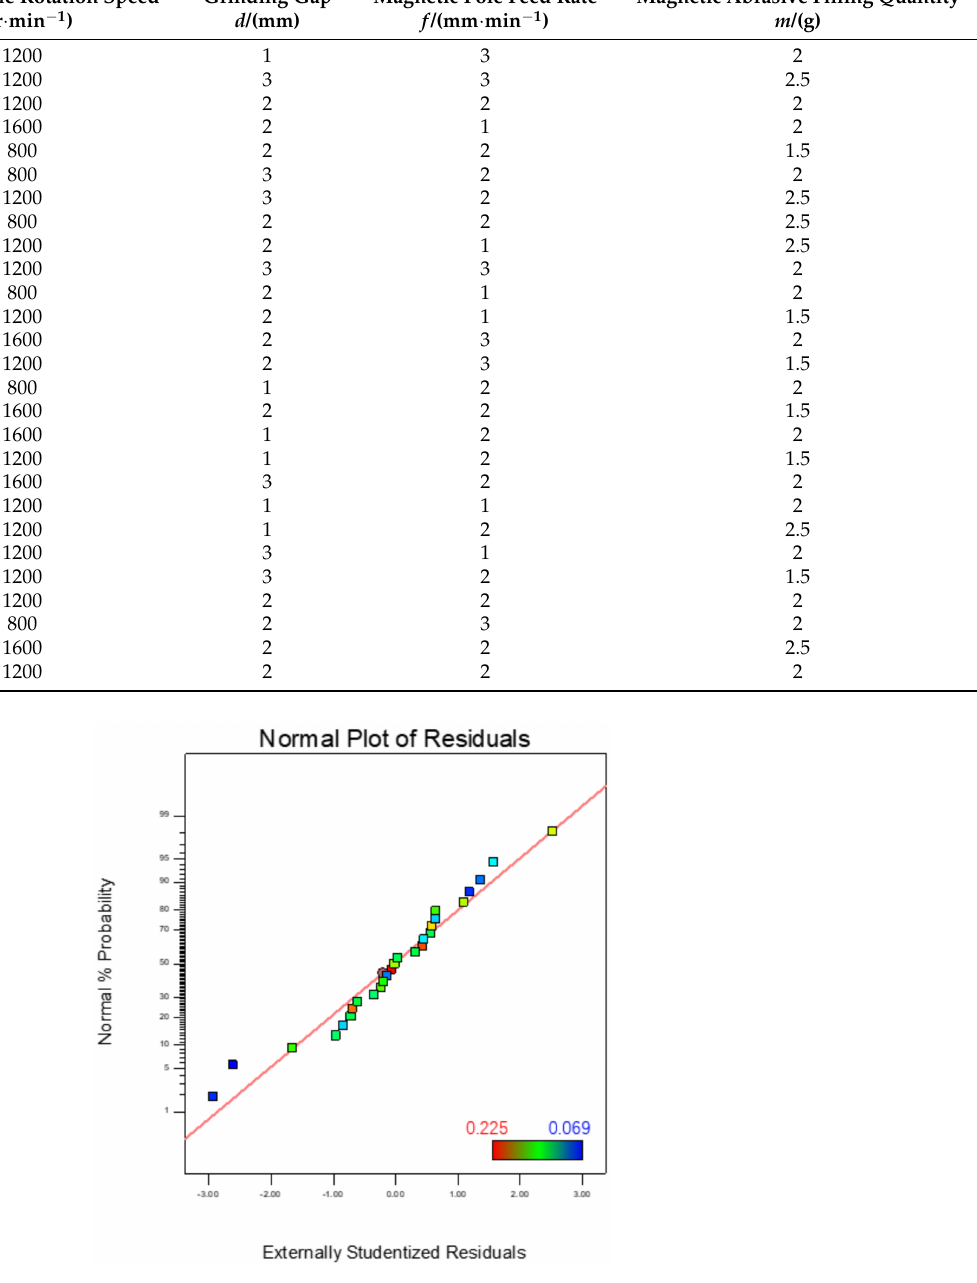
Figure 9. Residual normal probability distribution of surface roughness prediction model. Table 5 shows the ANOVA results of the surface roughness regression model. The F-value represents the significance of the whole regression equation model and p represents the significance level of the regression equation model. The number of independent vari- ables is 14 and the degree of freedom is 12. Checking the F-test (F-test) critical value table, the standard F-value for the given significance level at the significant level α = 0.05 is 2.534, and the F-value of the regression model of surface roughness is 22.53 > F 0.05 (14,12) = 2.424, indicating that the prediction model of the regression equation established between sur- face roughness and the four independent variables was highly significant, indicating a high degree of confidence in this prediction model. The misfit p value is 0.0668 > 0.05, which is not significant relative to the pure error. Analysis of the p values and F